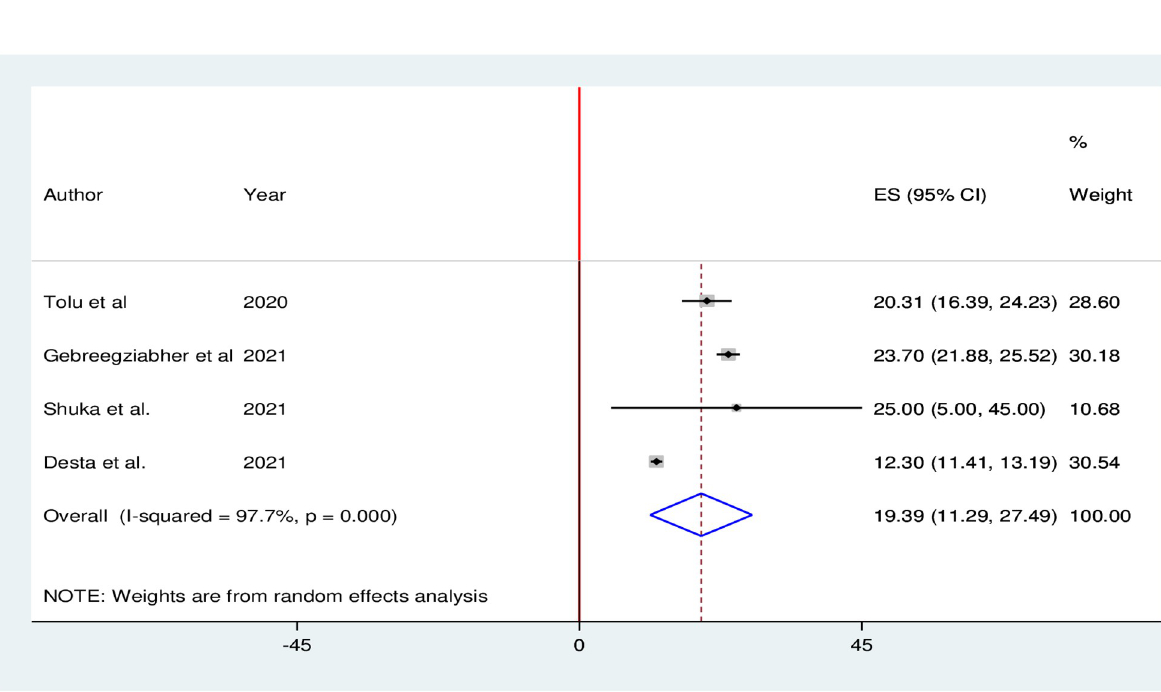
PLOS ONE | https://doi.org/10.1371/journal.pone.0281260 February 7, 2023 15 /